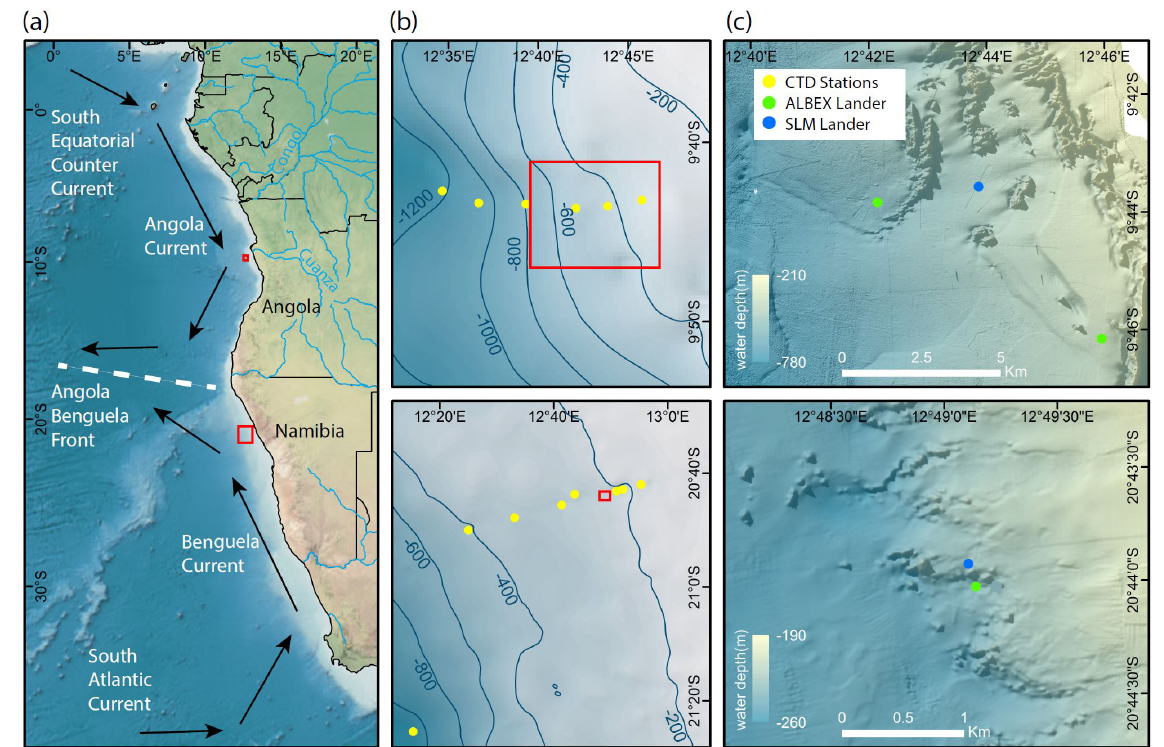
Figure 1. (a) Overview map showing the research areas off Angola and Namibia (red squares) and main features of the surface water circulation (arrows) and frontal zone (dashed line) as well as the two main rivers discharging at the Angolan margin. Detailed bathymetry maps of the Angolan (upper maps) and Namibian margins (lower maps) showing the position of (b) CTD transects (note the deep CTD cast down to 1000m water depth conducted off Namibia) and (c) bottom lander deployments (red squares shown in b indicate the cutouts displayed in c